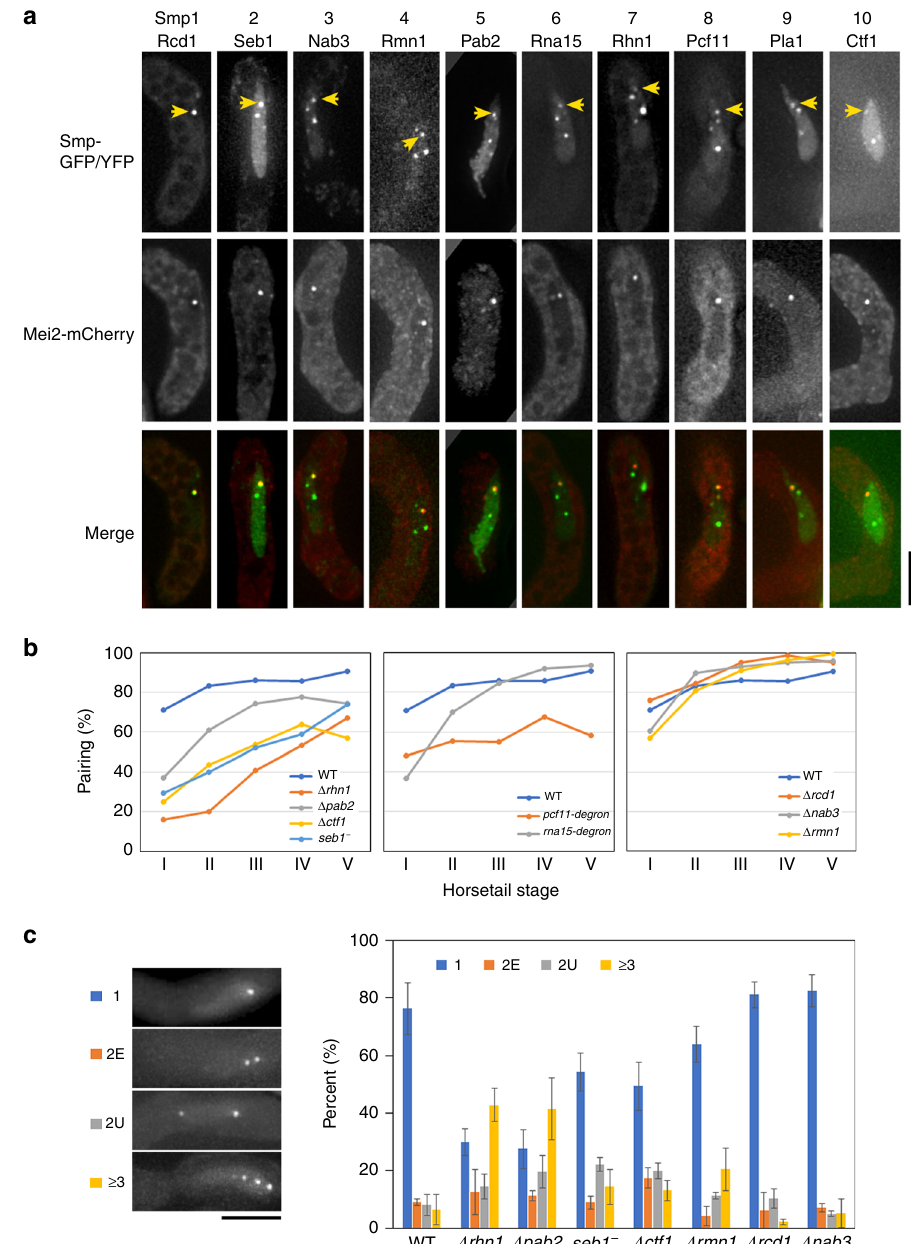
Fig. 1 Smp proteins are required for robust pairing at the sme2 locus. a Localization of Smp1 – Smp10 proteins fused with GFP or YFP in the horsetail nucleus. Arrows indicate co-localization with Mei2-mCherry. Meiosis was induced in the homothallic strains expressing YFP-fused or GFP-fused Smp protein and Mei2-mCherry. Three-dimensional fl uorescence images of YFP/GFP and mCherry were acquired in live zygotes. Yellow arrows indicate the position of Smp protein co-localized with Mei2 at the sme2 locus. Scale bar, 5 μ m. b Pairing frequency (%) of the sme2 locus in wild type (WT) and various defective mutants of Smp proteins: Δ rhn1 , Δ pab2 , Δ ctf1 , seb1-E38 , pcf11-degron , rna15-degron , Δ rcd1 , Δ nab3 , and Δ rmn1 . The number of cells examined is provided in a Source Data fi le 1b. Characterization of the pcf11-degron , rna15-degron , and seb1-E38 mutants, is shown in Supplementary Fig. 2. Cells of all the strains were induced to meiosis at 26 °C. The sme2 loci at distance ≤ 0.35 μ m were counted as paired, and pairing frequencies were plotted for fi ve substages (I – V) of the horsetail stage. Percentile rank plots of the distance between homologous loci are shown in Supplementary Fig. 3. Source data for Fig. 1b and Supplementary Fig. 3 are provided as a Source Data fi le 1b. c Frequency (%) of the number of sme2 RNA dots in WT and various Smp-defective mutant cells at the horsetail stage. The RNA dots were classi fi ed into four classes (1 for a single dot, 2E for 2 RNA dots with equal size, 2U for 2 RNA dots with unequal size, and >3 for more than 2 dots). Representative images for one to three or more dots are shown on the left. Two dots with equal size (2E) or unequal size (2U) were counted separately. Class 2E likely represents sme2 RNA accumulated at each of the homologous sme2 loci. More than 60 horsetail nuclei in an asynchronous population were observed for each strain, in three independent experiments; the precise number of cells examined is provided in a Source Data fi le 1c. Error bars indicate standard deviation. Scale bar, 5 μ m. Source data for Fig. 1c are provided as a Source Data fi le